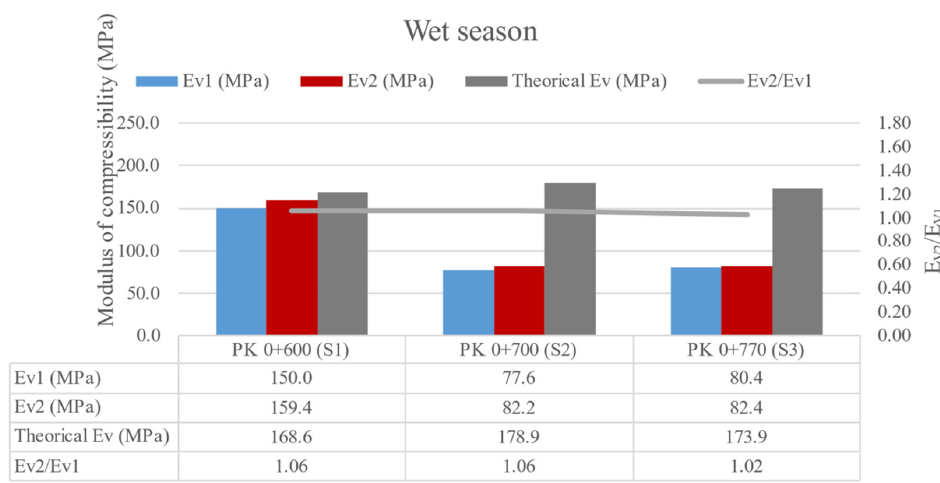
Figure 16. Plate bearing test results in the wet season.